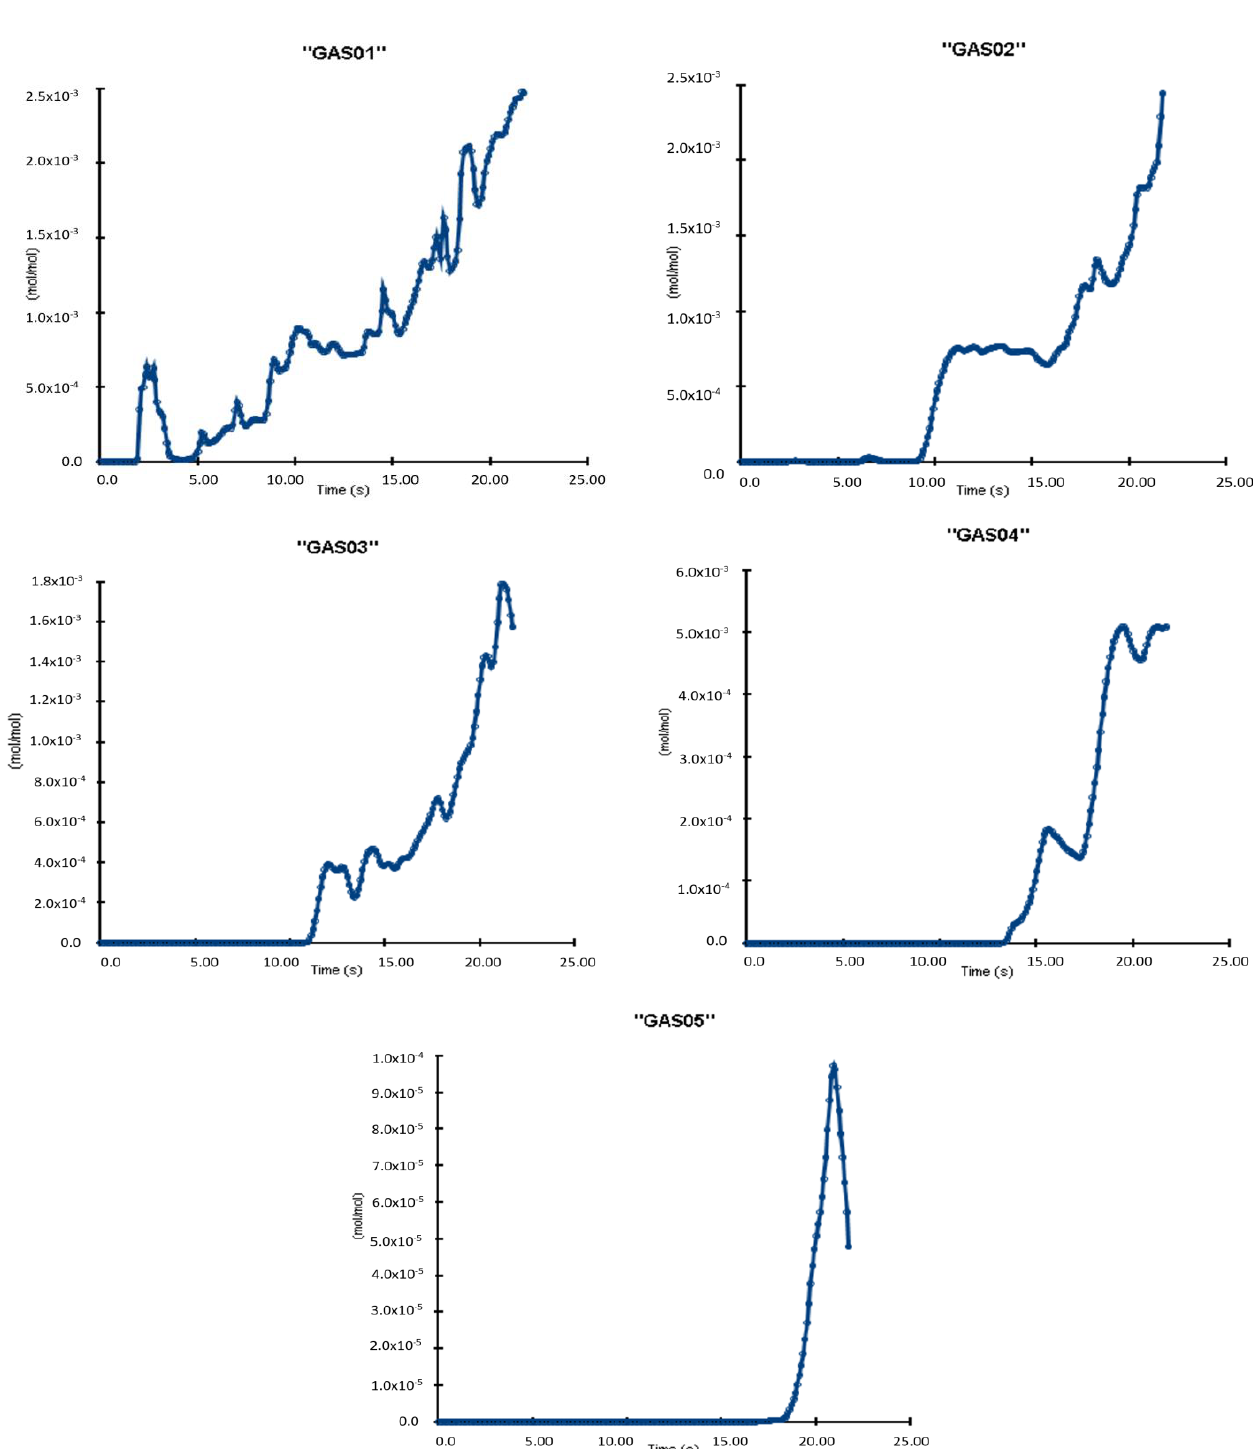
Figure 18. CO volume fraction diagrams (mol/mol).